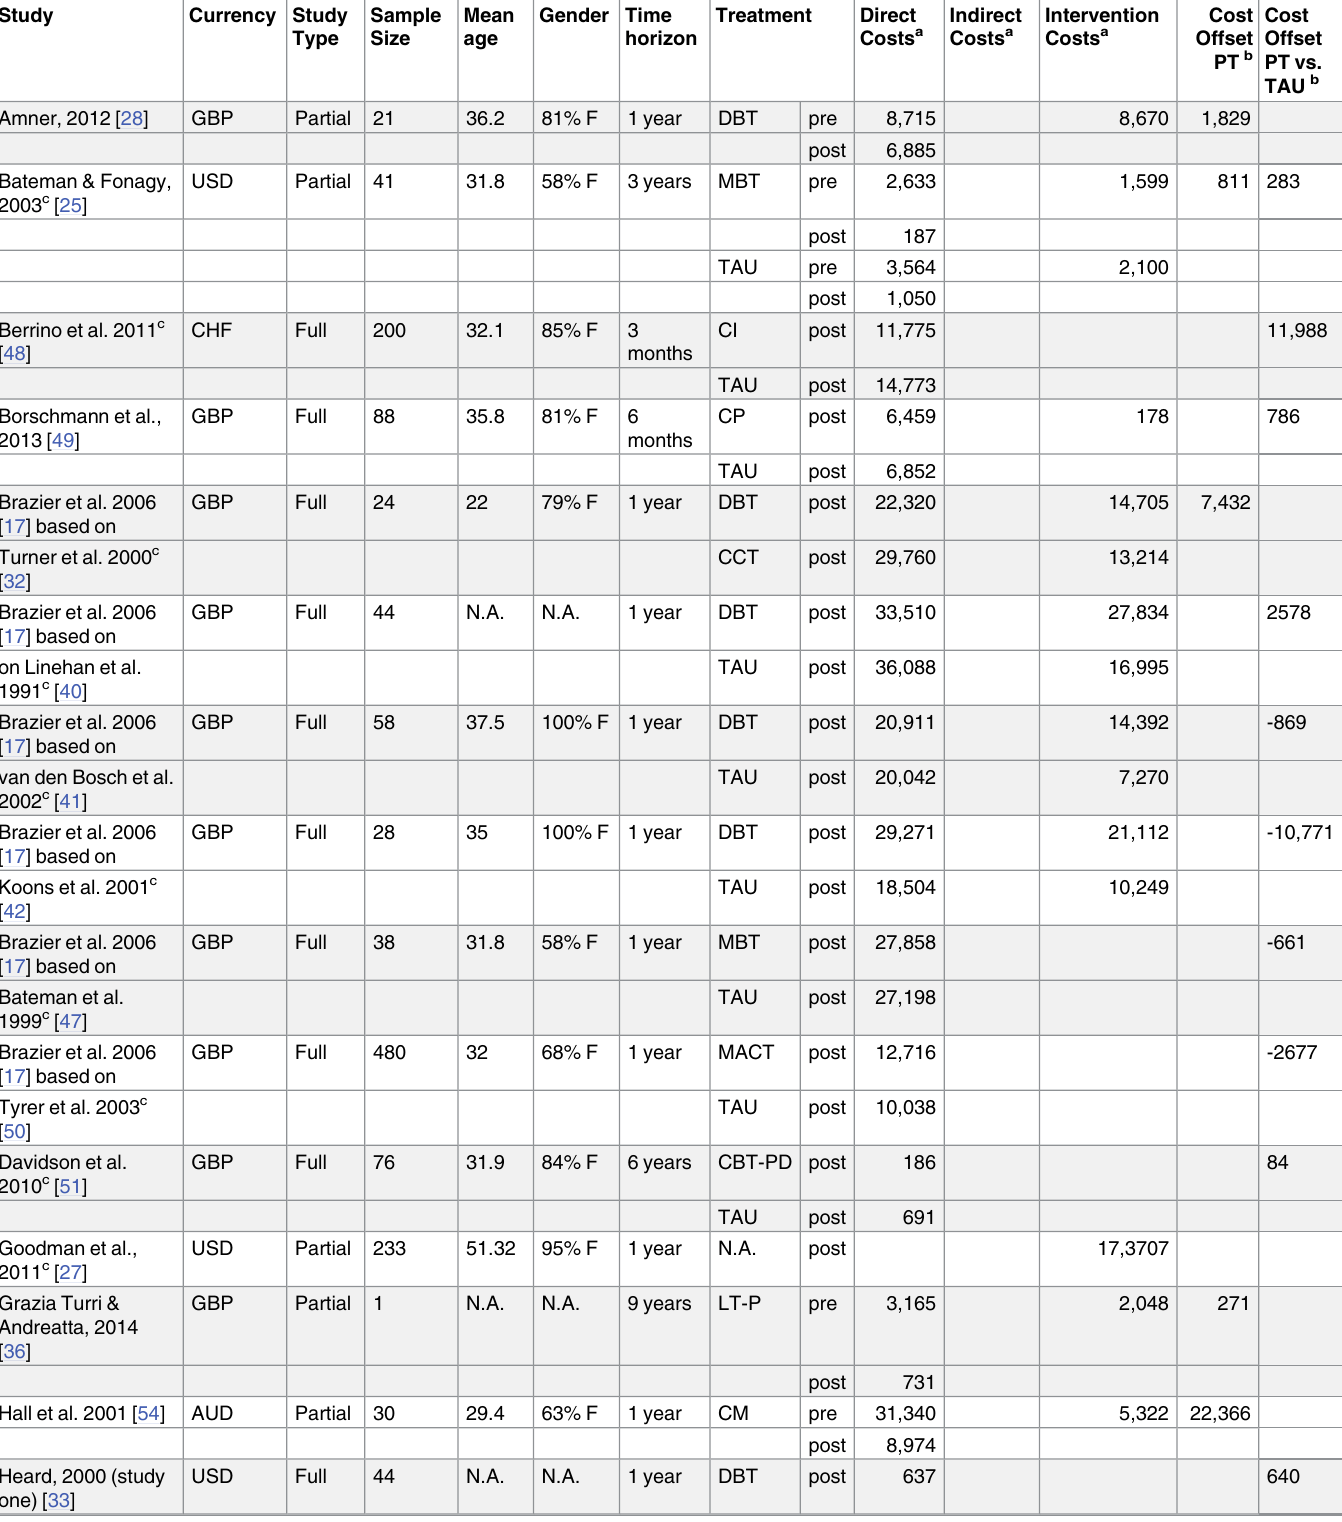
Table 1. Summaryof the cost differences in the economic evaluations reviewed (indirect/direct + intervention costs calculated for 2015, per patient, time horizon as